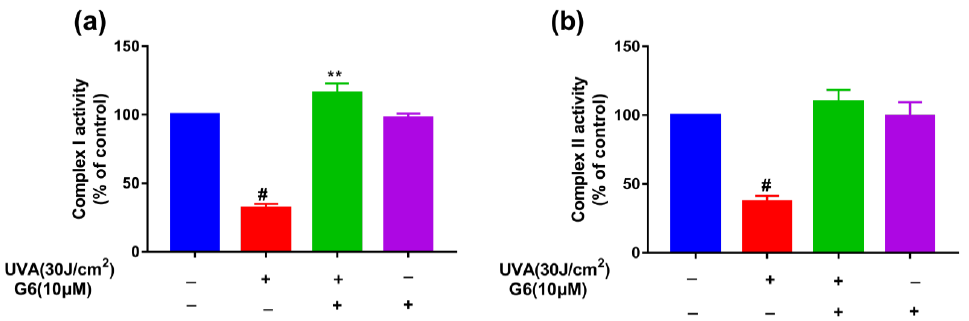
Figure 6. Effect of G6 on mitochondrial functions. ( a ) Activities of complex I; ( b ) activities of complexe II. (blue color, the control group; red color, treated with 30 J/cm 2 UVA; green color, treated with 30J/cm 2 UVA and 10 μM G6; black color, treated with 10 μM G6.) The values are presented as the means ± S.E.M from at least three independent experiments. Significant difference from control group: ** p < 0.01 and # p < 0.0001.